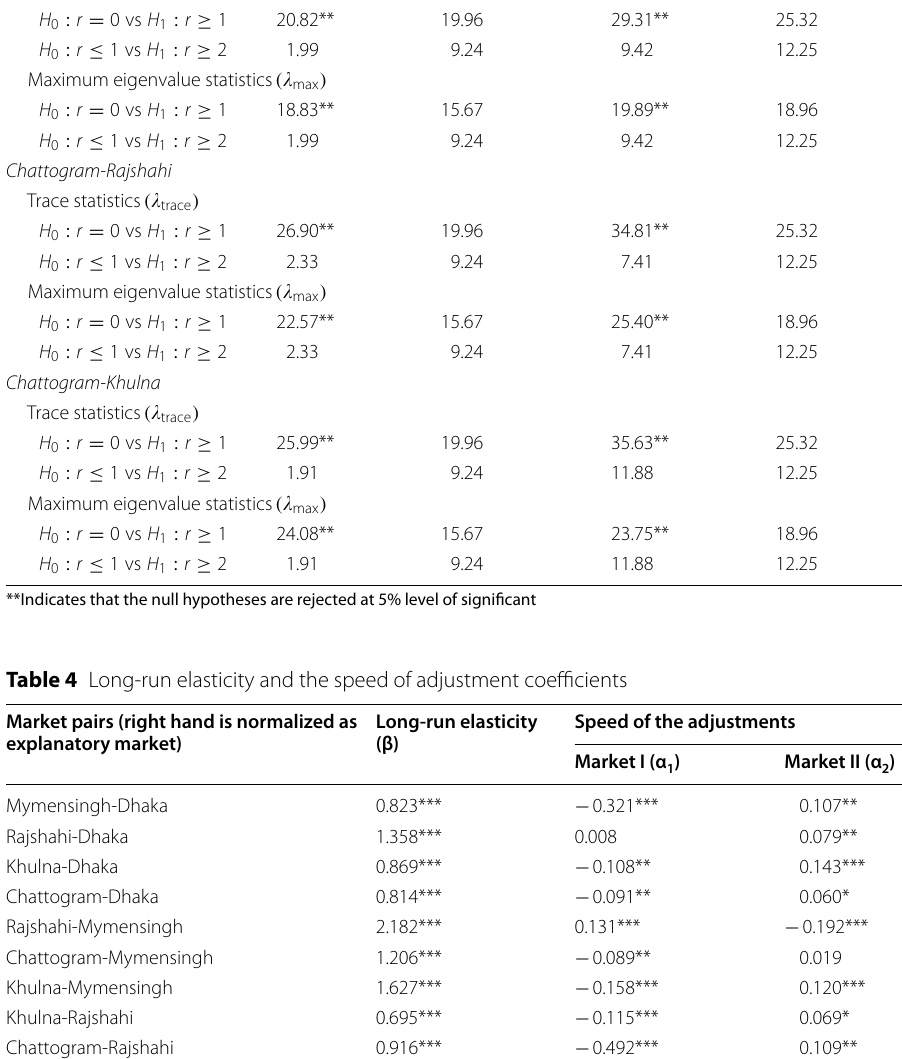
*, ** and *** indicate that the null hypotheses are rejected at 1%, 5% and 10% level of significant, respectively; Market I and Market II indicate the first and second market in each market pair, for example in Mymensingh-Dhaka market pair, Mymensingh is Market I and Dhaka is Market II